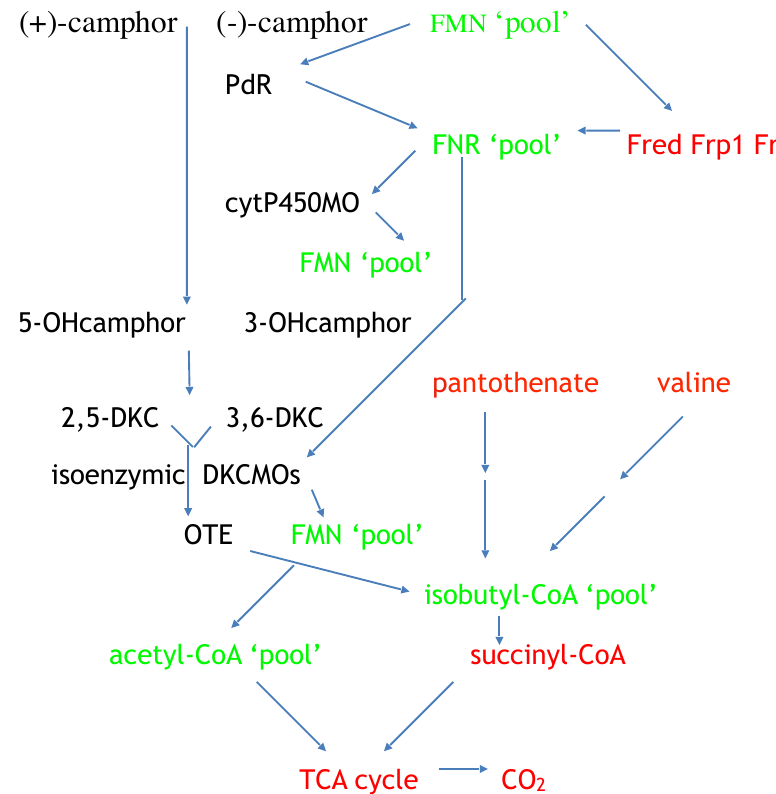
Figure 15. Key interrelationships between CAM plasmid-coded functions and chromosome-coded functions in ( rac )-camphor-grown P. putida ATCC 17453. black = biomolecules exclusive to CAM plasmid-directed biochemistry: red = biomolecules exclusive to chromosome-directed biochemistry: green = biomolecules common to both plasmid-directed and chromosome-directed biochemistry. DKC = diketocamphane; FNR = FMNH 2. ; cytP540MO = camphor 5-monooxygenase; OTE = 2-oxo- (cid:52) 3 -4,5,5-trimethylcyclopentylacetic acid; PdR =